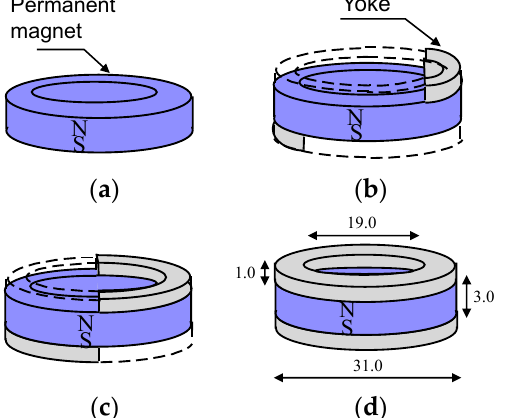
Figure 4. Structure of the permanent magnet with a yoke (unit: mm). ( a ) θ m = 0 (deg); ( b ) θ m = 45 (deg); ( c ) θ m = 90 (deg); ( d ) θ m = 360 (deg). The coil conductor diameter was 0.1 mm, and it was wound 1872 times around